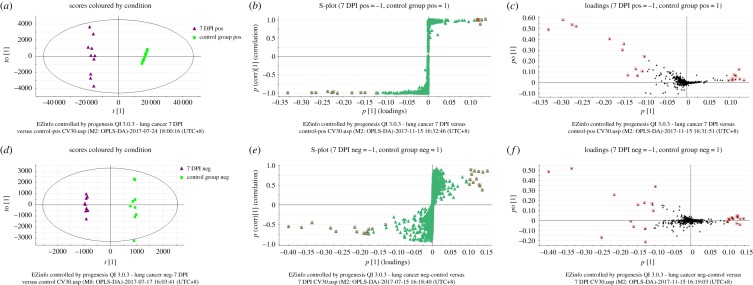
Score plot, corresponding S-plot and loading-plot from the OPLS-DA model between the 7 DPI group and control group. Score plot (a) generated from the OPLS-DA model between the 7 DPI and control group in positive ion mode (R2Y = 79%, Q2 = 58%), and corresponding S-plot (b) and loading-plot (c) from the OPLS-DA model. Score plot (d) generated from the OPLS-DA model between the 7 DPI and control group in negative ion mode (R2Y = 95%, Q2 = 87%), and corresponding S-plot (e) and loading-plot (f) from the OPLS-DA model.